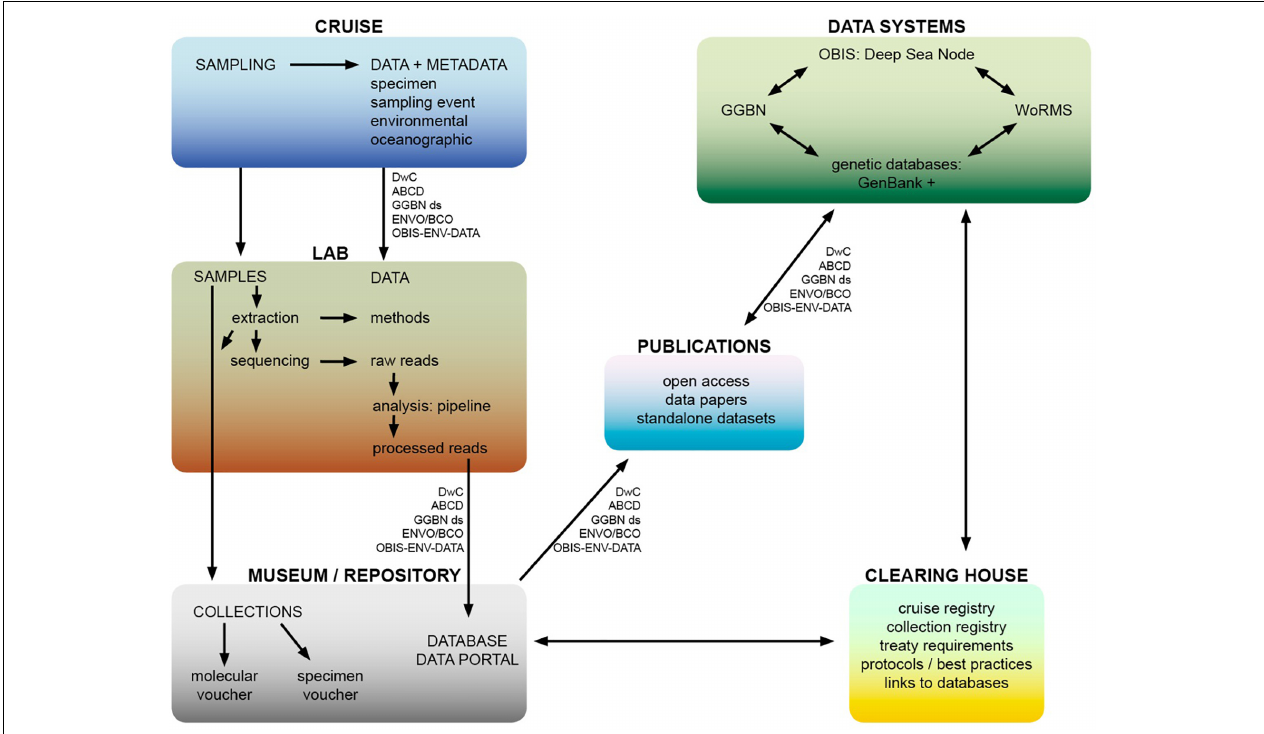
FIGURE 4 | Potential workflow from cruise to data publication of access to MGR from ABNJ, including the scope of a potential clearing-house mechanism. Data standards are also shown, acronyms are as follows – Dwc: Darwin Core, ABCD: Access to Biological Collection Data GGBN ds: Global Genome Biodiversity Network data standard, ENVO: Environment Ontology, BCO: Biological Collections Ontology, OBIS-ENV-DATA: OBIS extendedMeasurementorFact DarwinCore Extension. These data standards are also listed in Table 1